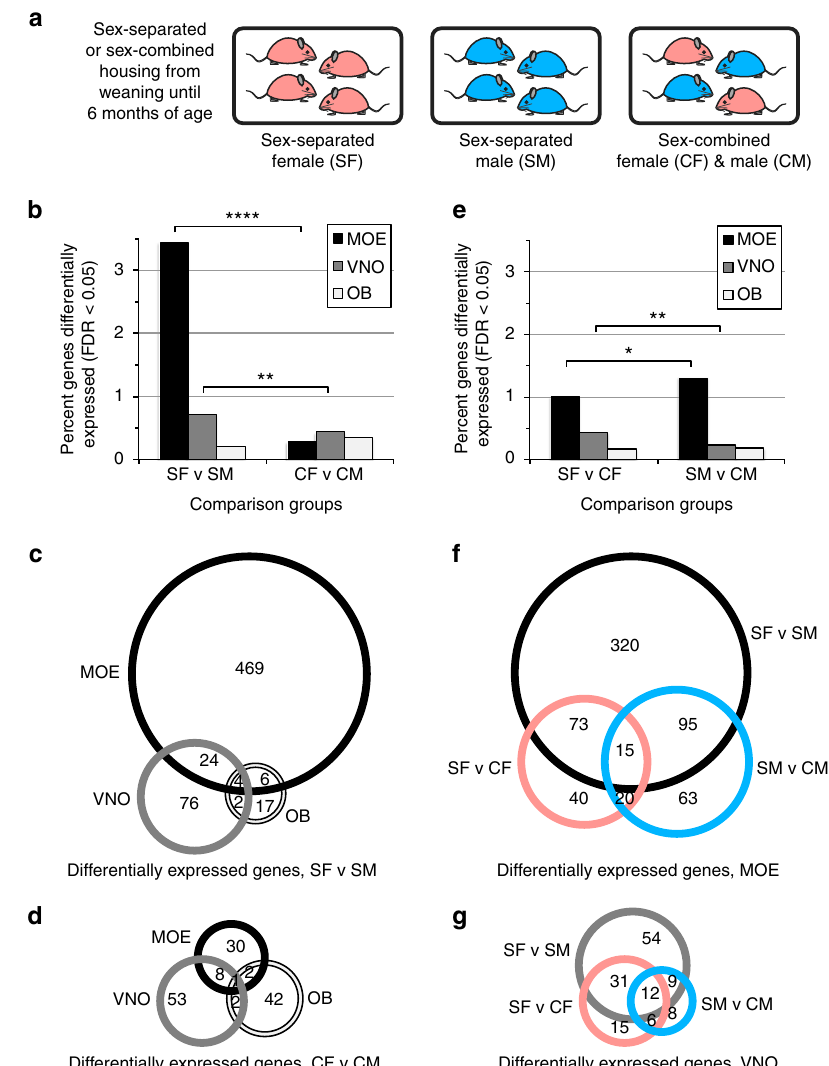
Fig. 1 Sex separation induces gene expression differences between male and female mice in MOE and VNO tissues. a Experimental set-up. From weaning (P21) until 6 months of age, mice experienced either a sex-separated environment, in which mice were housed either 4 females/cage (left) or 4 males/ cage (middle), or a sex-combined environment (right), in which mice were housed 2 females + 2 males/cage. b Percentage of expressed genes that were identi fi ed via RNA-seq as signi fi cantly differentially expressed (FDR < 0.05) within MOE, VNO, and OB tissues between male and female sex-separated (SF versus SM) and sex-combined (CF versus CM) mice. c , d Venn diagram of expressed genes identi fi ed via RNA-seq as signi fi cantly differentially expressed (FDR < 0.05) within MOE, VNO, and OB tissues between male and female sex-separated (SF versus SM) ( c ) and sex-combined (CF versus CM) ( d ) mice. e Percentage of expressed genes that were identi fi ed via RNA-seq as signi fi cantly differentially expressed (FDR < 0.05) within MOE, VNO, and OB tissues between sex-separated and sex-combined female (SF versus CF) and male (SM versus CM) mice. f , g Venn diagram of expressed genes identi fi ed via RNA-seq as signi fi cantly differentially expressed (FDR < 0.05) within MOE, VNO, and OB tissues between sex-separated and sex-combined female (SF versus CF) ( f ) and male (SM versus CM) ( g ) mice. SF sex-separated females, SM sex-separated males, CF sex-combined females, SM sex-combined males. * p < 0.05, ** p < 0.01, **** p <0.0001 (Chi-squared